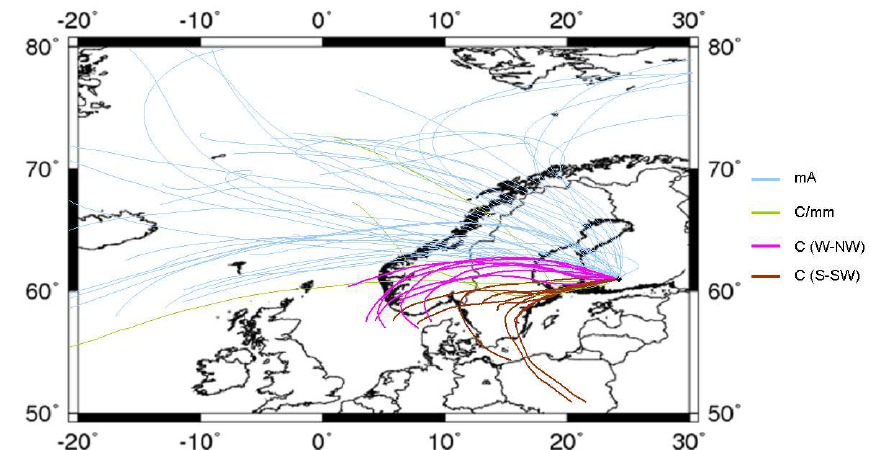
Fig. 2. Back-trajectory plots (48h backward, 500m AGL height) obtained by running the HYSPLIT model every four hours from 28 March to 21 April. Colours are used for distinct air masses typologies: marine/Arctic (mA), Continental/modified marine (C/mm), Continental from the W–NW sector and Continental from the S–SW sector.